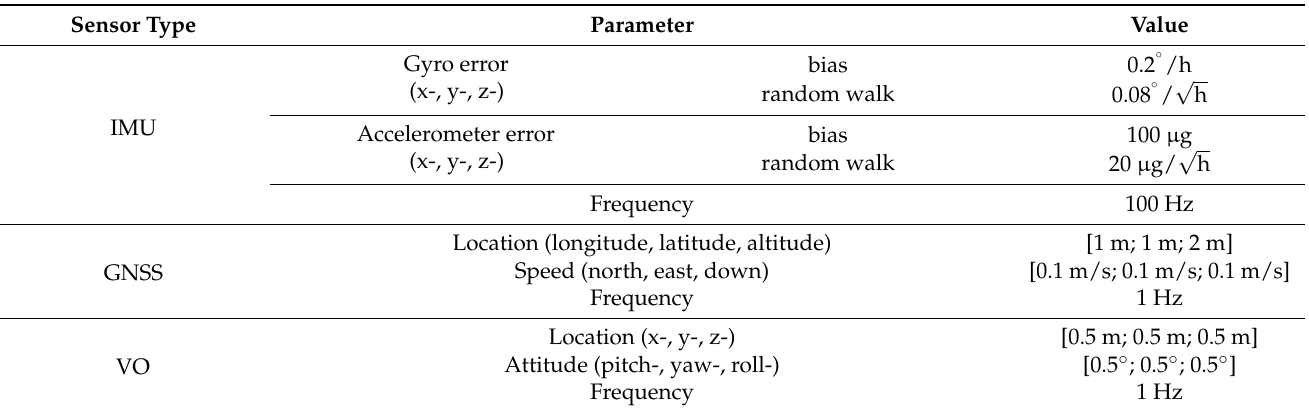
Table 1. Sensor parameter settings.